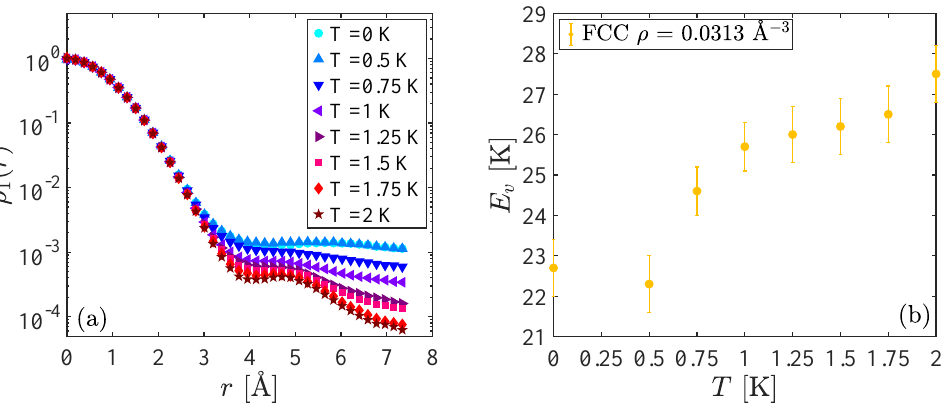
Figure 2. Results for a fcc crystal at density ρ = 0.0313 Å − 3 : ( a ) one-body density matrix ρ 1 ( r ) as a function of the interatomic distance r , for different values of the temperature T (error bars are below symbol size); and ( b ) vacancy formation energy E v as a function of the